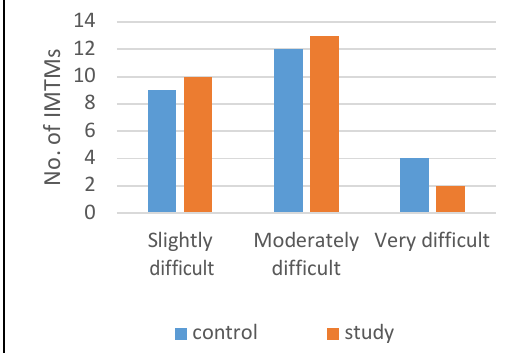
Figure 6: Distribution of impacted teeth according to Pederson difficulty index Adding to that no significant difference were